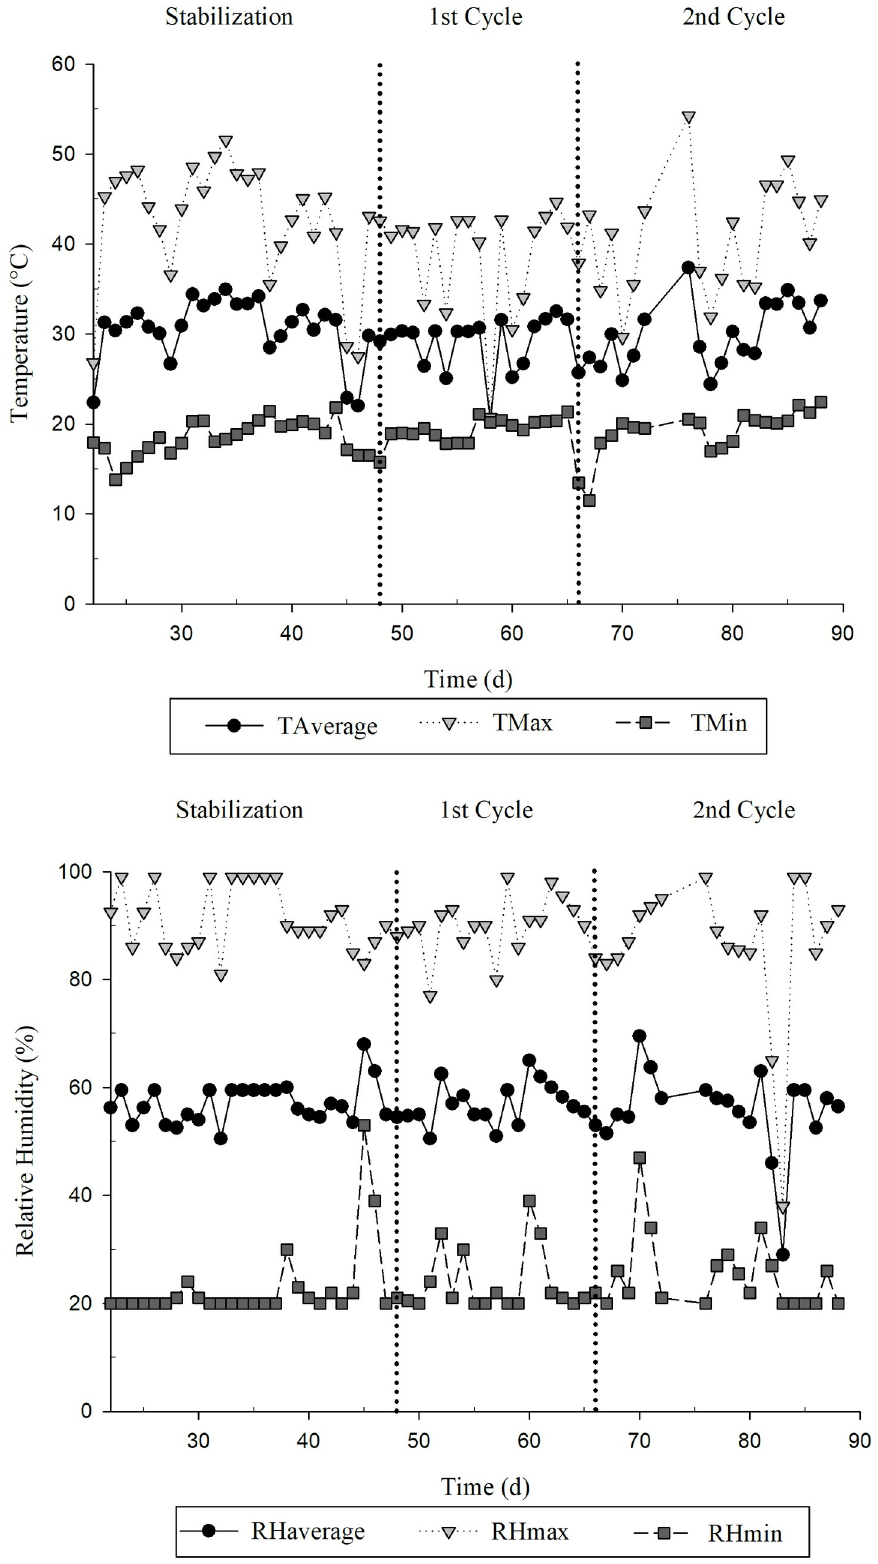
Fig 2. Temperature and relative humidity within the